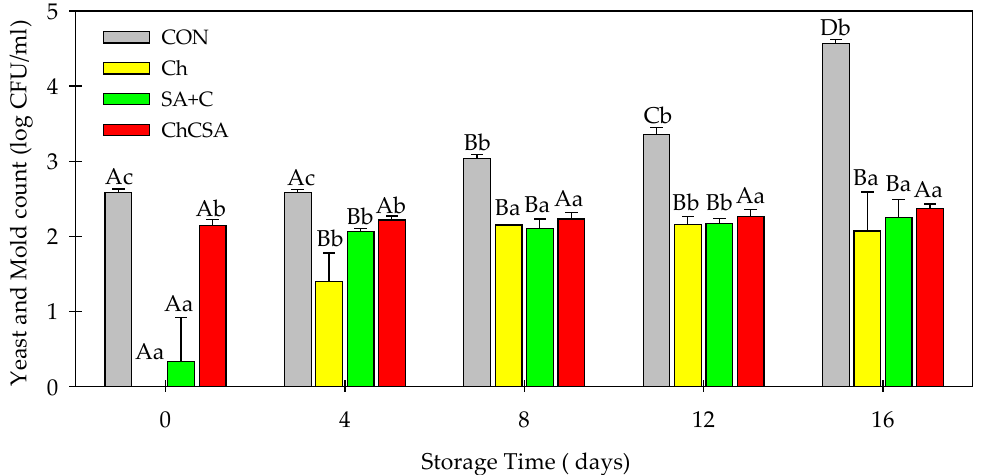
Figure 5. The effect of single-layer and gel coatings on the yeast and mold on fresh-cut purple sweet potatoes. Vertical bars represent means and standard deviation. Bars with different alphabets within the same storage day (lower case) or same treatment group at different storage days (upper case) are significantly different (Tukey’s HSD Test, p ≤ 0.05).